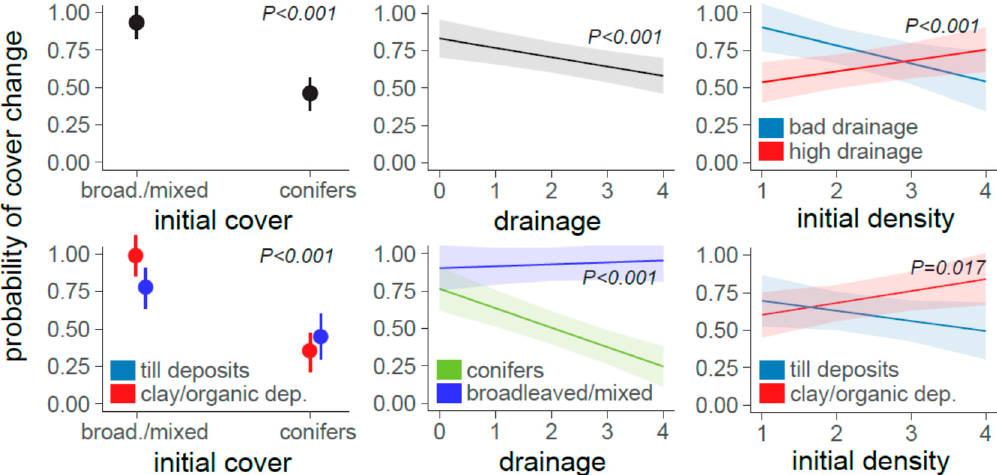
Figure 3. Results of overall probability of cover changes modeling. The plots show the predicted values and 95% confidence intervals obtained with the selected linear mixed model that account for initial forest cover, sites characteristics and their interactions (R 2 fixed = 0.30; R 2 fixed + random = 0.43). Black and white plots show single e ff ects while colored plots show interaction e ff ects. Only significant ( p < 0.05) e ff ects and interactions are shown (except for forest initial density that had a significant but very weak negative e ff ect). Drainage classes range from bad (0) to good (4), and initial tree cover density ranges from low (1; 0–25%) to high (75–100%).